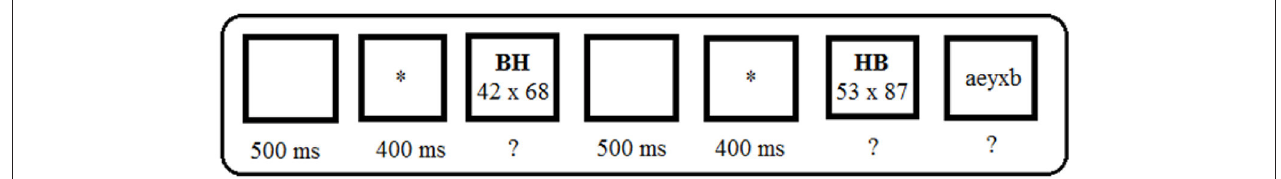
FIGURE 1 | Events within a sequence. The letters “BH” (i.e., standing for “down-up” in French) cued participants to use the mixed-rounding down-up strategy, and the letters “HB” (i.e., standing for “up-down” in French) prompted participants to use the mixed-rounding up-down